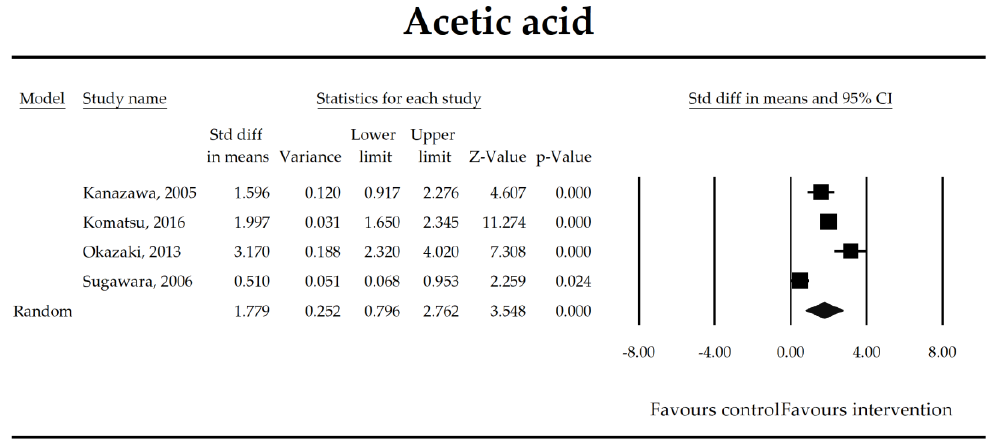
Figure 7. The effect size (standardized mean difference) for the concentration of acetic ratio in patients taking probiotics (intervention) vs. no probiotics (control).